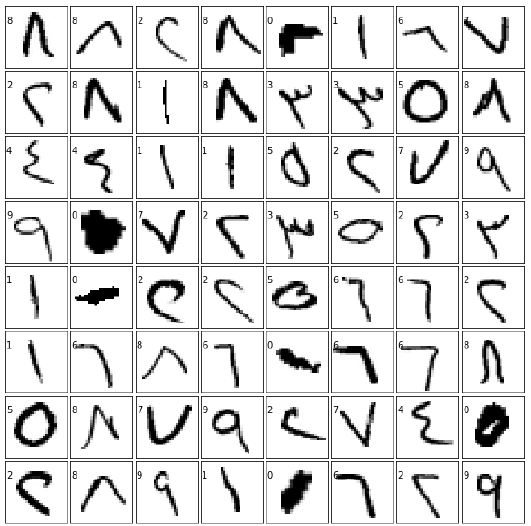
Figure 2. Random character samples from the MADBase [10] dataset (28x28